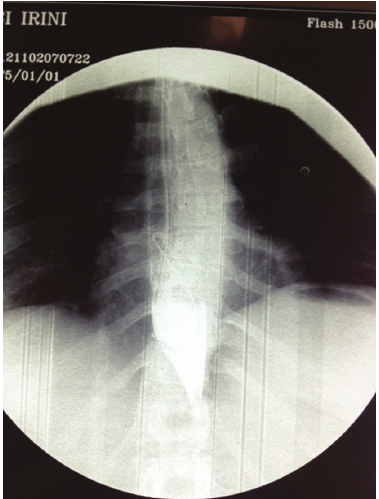
Figure 1: “Bird beak” sign and helical trend of the nasogastric tube after gastrografin swallow.